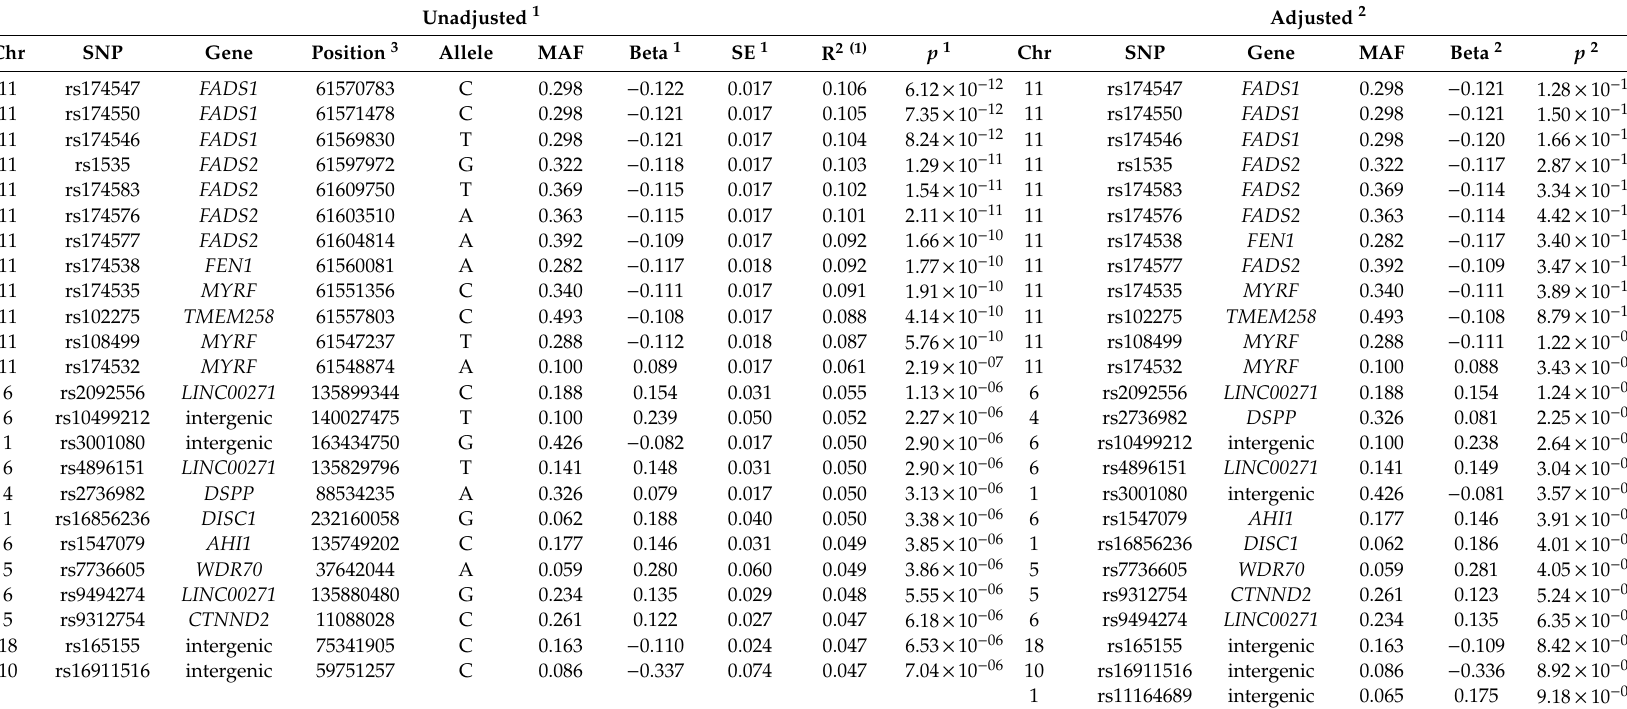
Table 3. Top-ranked SNPs in the GWAS for docosahexaenoic fatty acid concentrations (%) in the whole